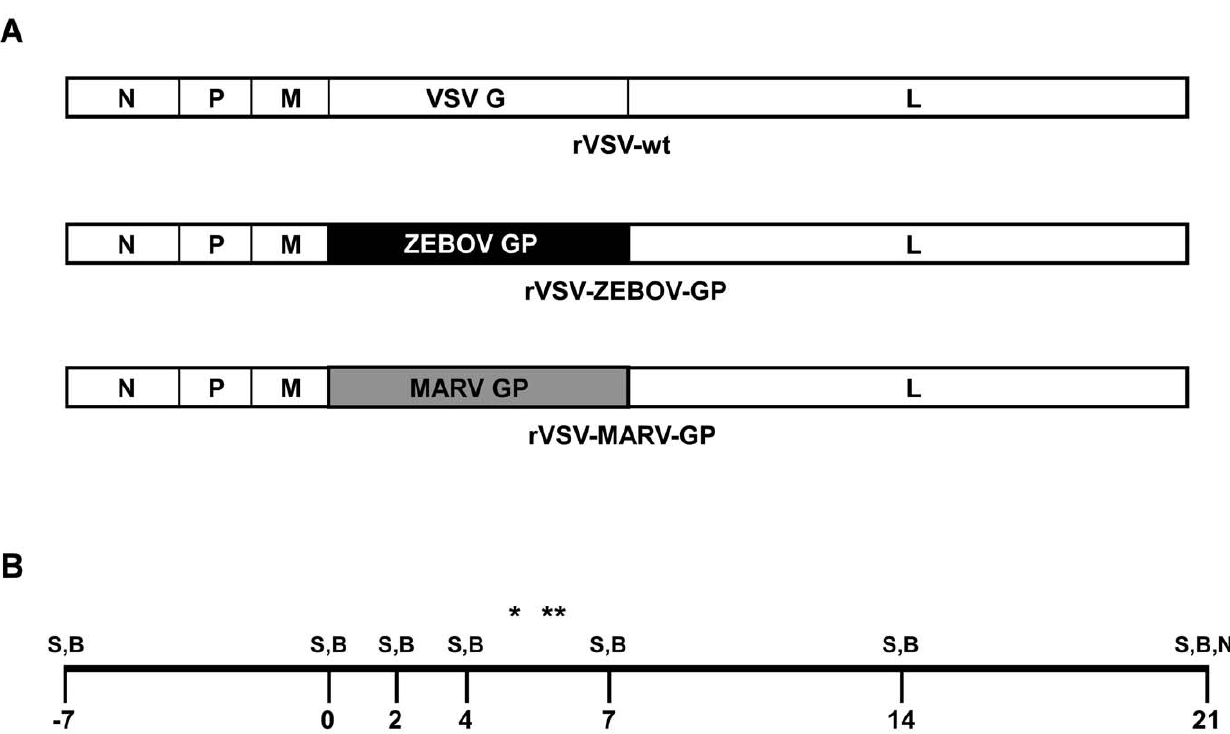
Figure 1. Neurovirulence assay design. (A) Illustration of the rVSV genomes used in the IT inoculation procedures. Note that the only difference between the rVSV vectors used in this study were the glycoproteins. (B) Schematic of the sampling days during the 21 day study. S=swab, B=blood, N=necropsy, * day 5 necropsy of 67-01, ** day 6 necropsy of 56-09.